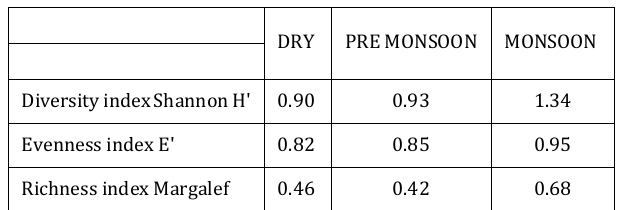
Table 4: Diversity indices at Station 1